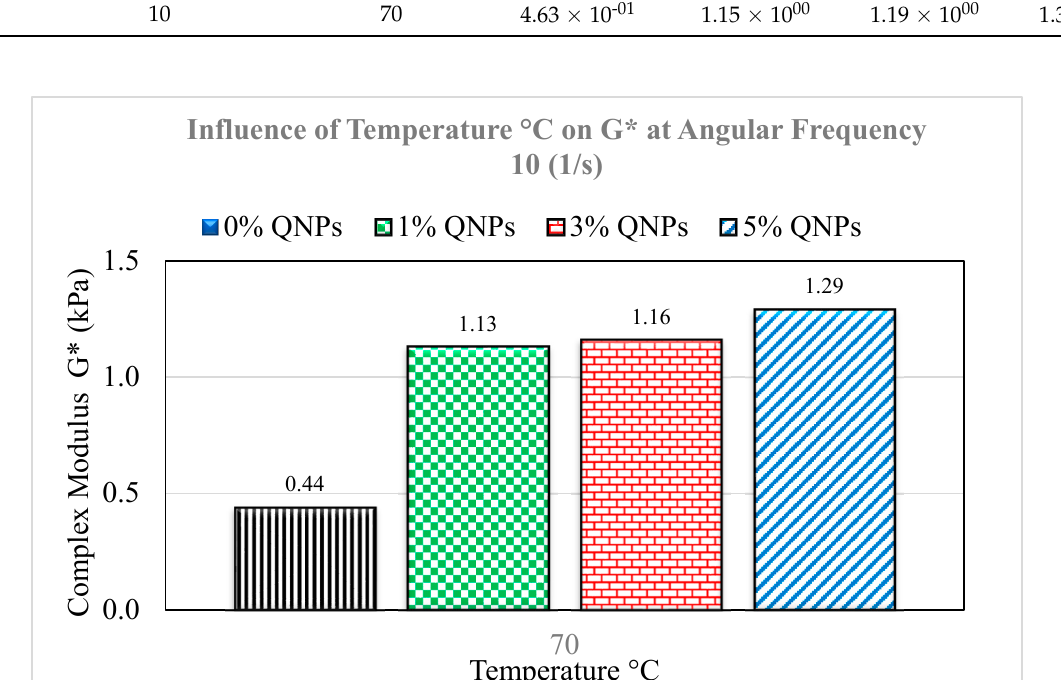
Figure 13. Graphical representation of the influence of temperature on G*.